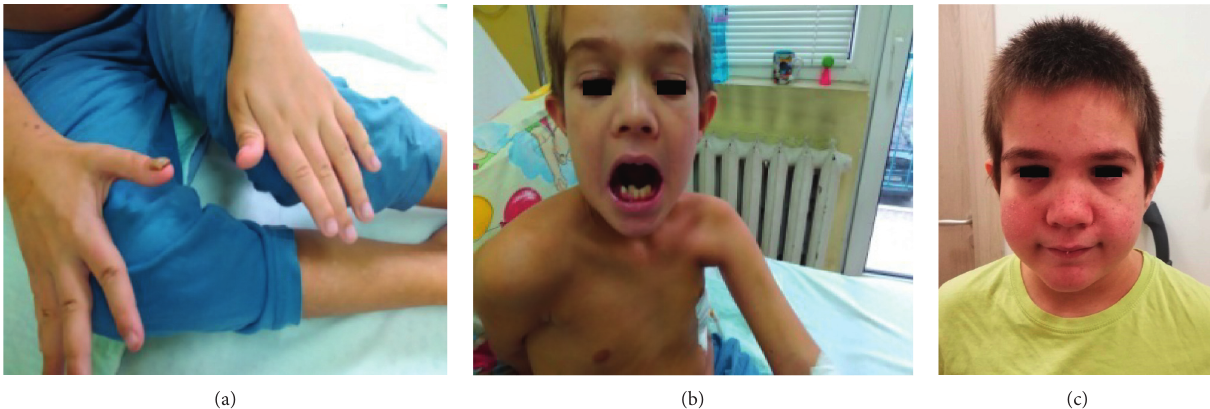
Figure 1: Data of some physical manifestations of Patient 1. (a) Onychomycosis of the thumbnail. (b) Retained deciduous teeth at 7 years. (c) Facial features at 11 years.